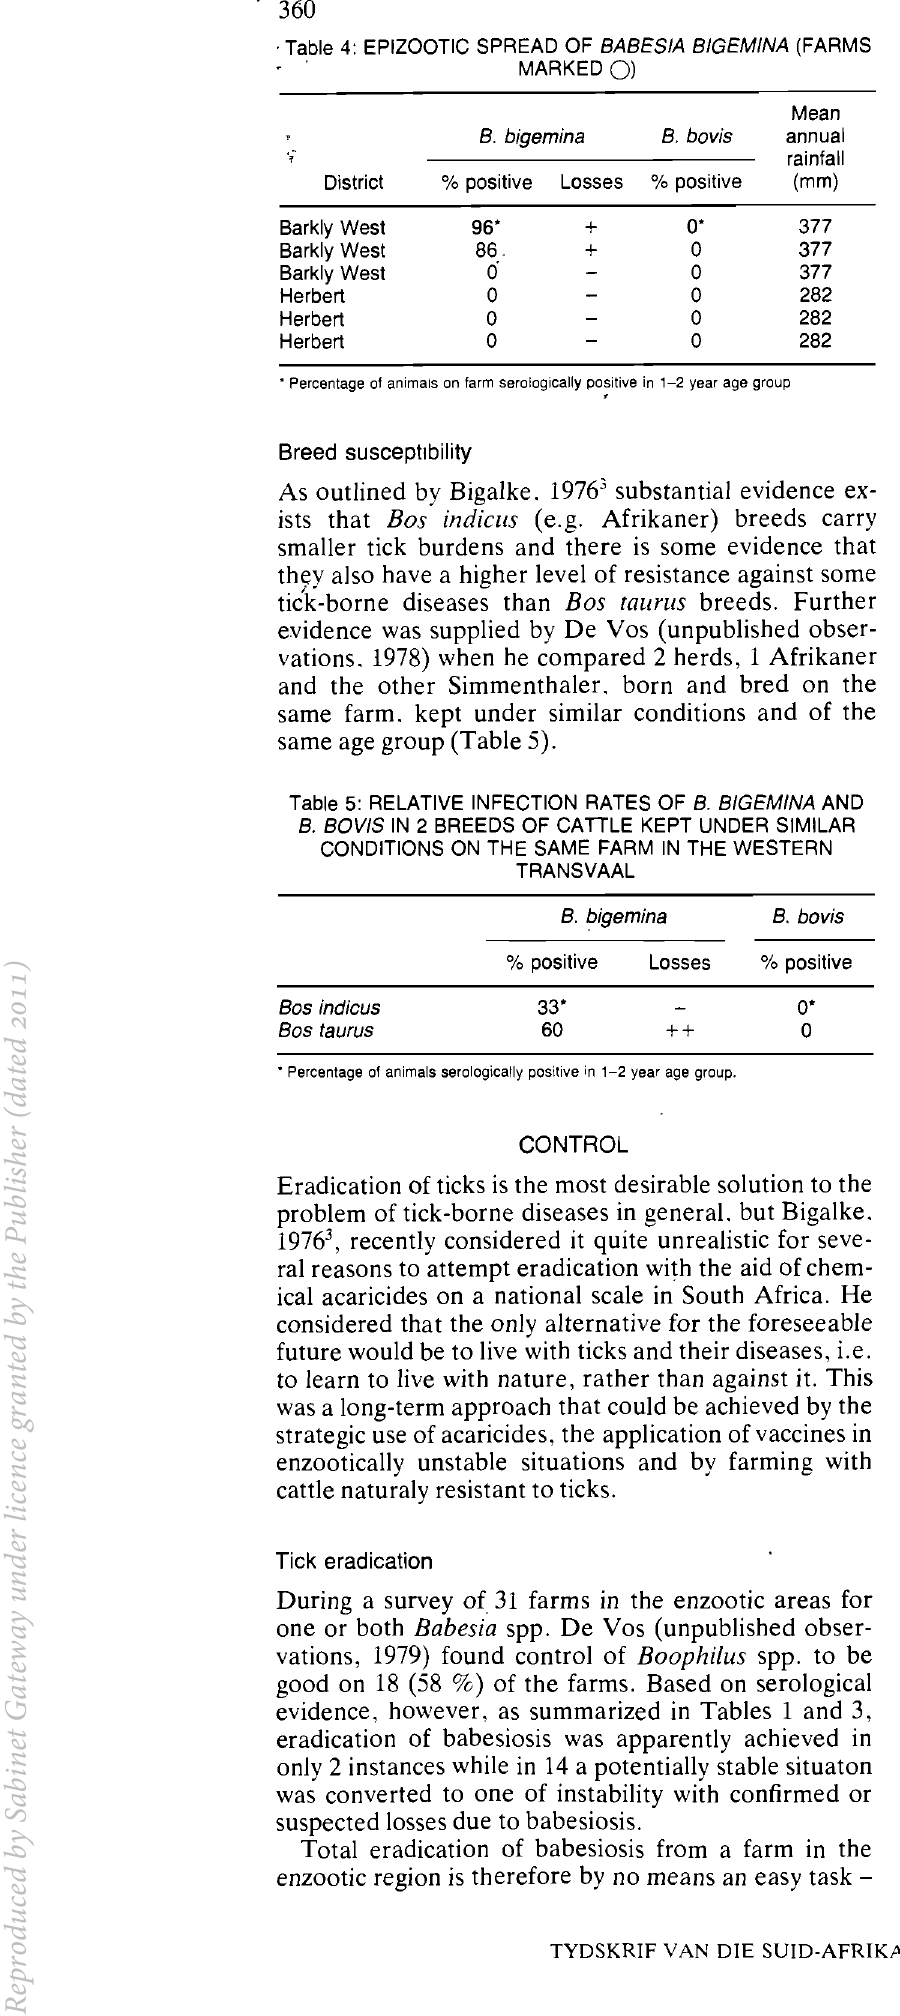
· Table 4: EPIZOOTIC SPREAD OF BABESIA BIGEMINA (FARMS .